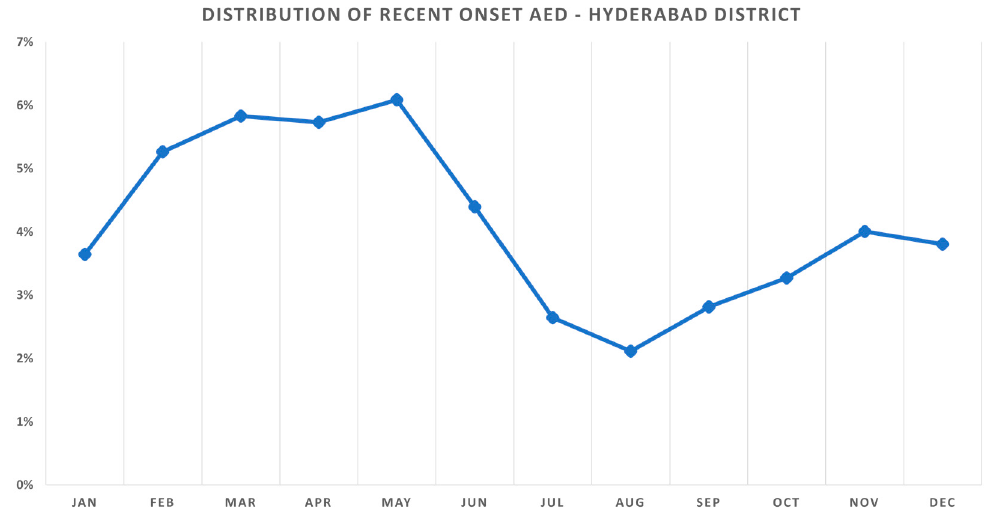
Figure 1. Seasonal variation of recent onset allergic eye disease (AED) in the district of Hyderabad. The prevalence of AED increased steadily from February (5.27%) during winter to peak in the month of May (6.09%) before decreasing with the onset of monsoon in July